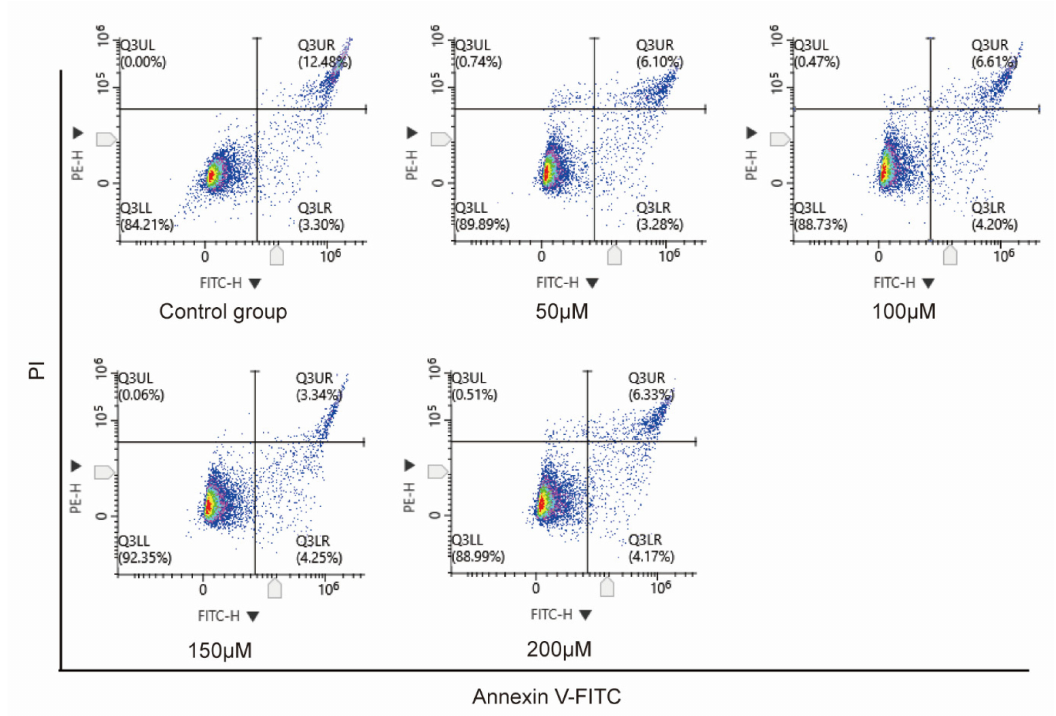
Figure 2. Cell apoptosis. Rotundine (0, 50, 100, 150, and 200 µ M) intervention in SW480 was followed by annexin V-FITC/PI staining to assess cell